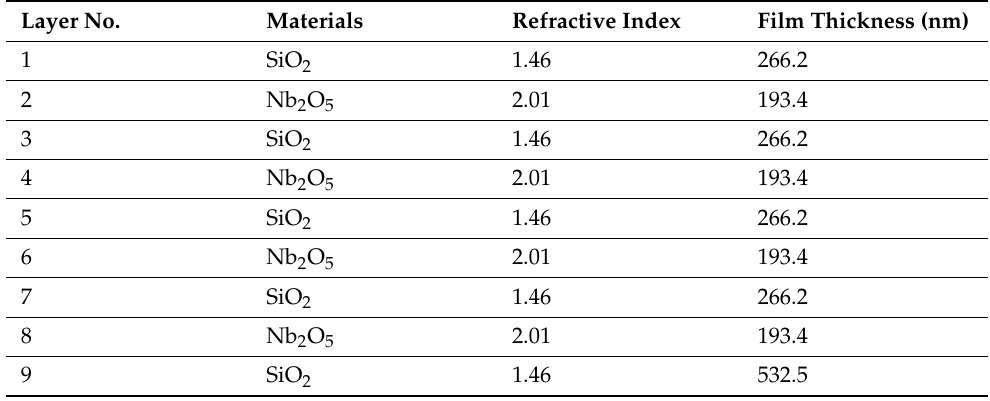
Table 1. Notch filter design of B270/SiO 2 (Nb 2 O 5 /SiO 2 ) 4 /air. Layer